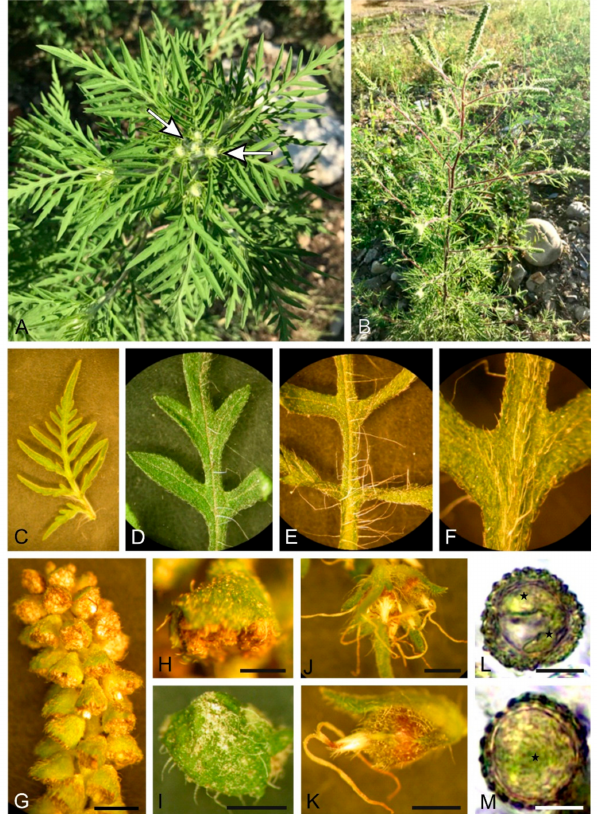
Figure 8. Stems, leaves, inflorescences, and pollen grains of Artemisia artemisiifolia : ( A ) shoot with inflorescence buds (arrows) in top view; ( B ) flowering plant; ( C – F ) leaves on the top part of the shoot; ( C , D ) adaxial surface of the leaf blade; ( E , F ) fragments of the abaxial leaf surface with numerous non-glandular trichomes; ( G ) fragment of an inflorescence with male capitula; ( H , I ) male capitula with an involucre bearing trichomes; ( J ) cluster of capitula with pistillate flowers; ( K ) capitulum with one pistillate flower equipped with two long pistil stigmata; ( L , M ) pollen grains with a visible layer of pollenkitt (asterisk) on the surface; Scale bars: G —3 mm, H – J —2 mm, K —1 mm, L , M —10 µ